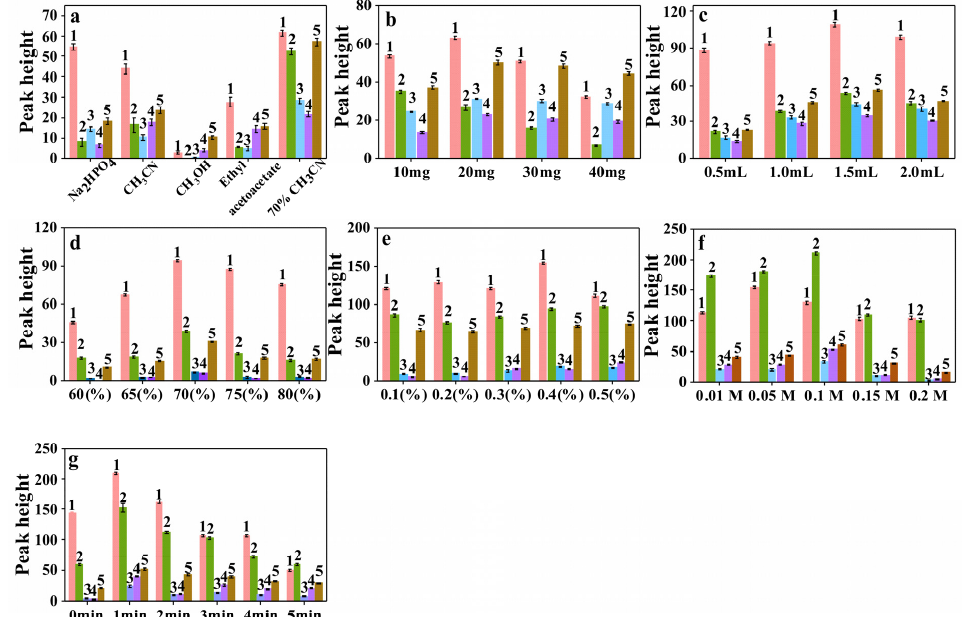
Figure 3. The effect of ( a ) desorbing solvent, ( b ) amount of Fe 3 O 4 @ZIF − 67, ( c ) desorbing solvent volume, ( d ) the proportion of acetonitrile in the desorbing solvent, ( e ) the concentration of formic acid to acidify the desorbing solvent, ( f ) the salt ion concentration in the sample solution, and ( g ) vortex time on MSPE performance (error bars indicate standard deviations from three